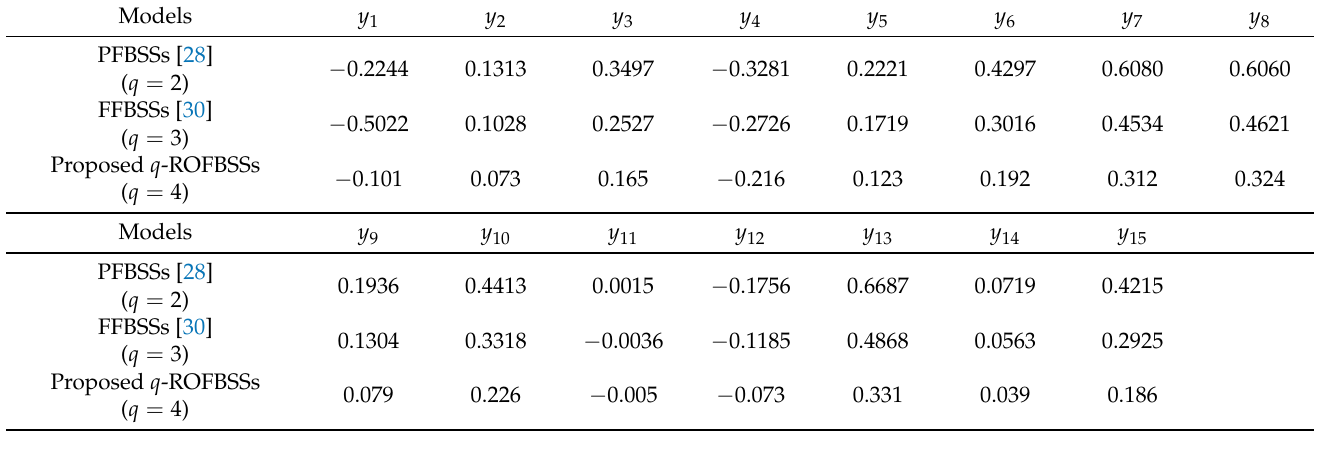
Table 18. Comparison table for the Application 2 (Selection of a house) in [28].